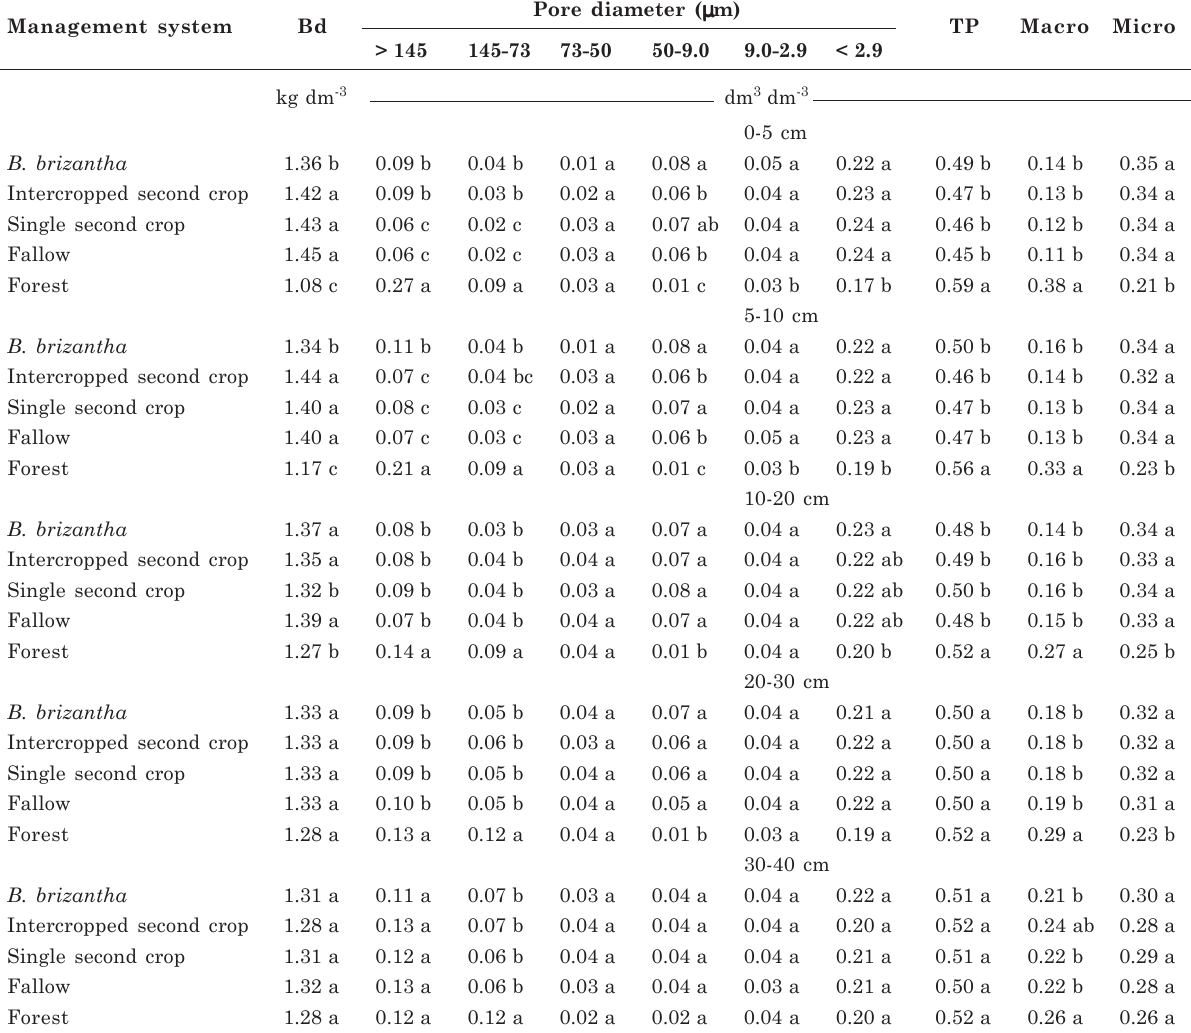
Table 4. Temporal distribution of soil bulk density (Bd) and pore size of the dystrophic Red Latosol at five depths and under different systems of soil use and management during the between-crop season of soybean